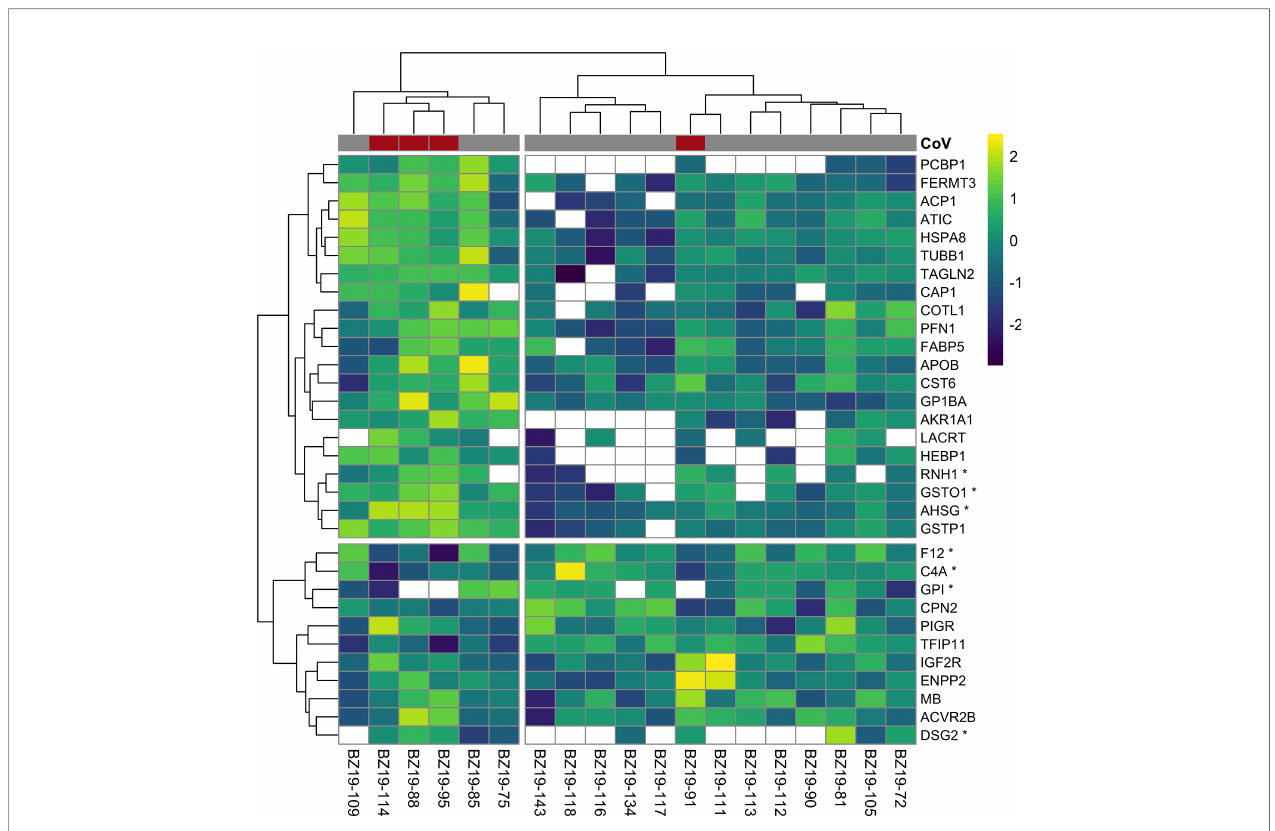
FIGURE 3 | Heatmap of log 2 -transformed abundance for all candidate serum biomarkers of CoV infection ( n = 32), scaled to a mean of zero. Rows display individual bats, while columns display proteins as gene symbols; those with AuROC ≥ 0.9 are marked with an asterix. CoV infection status is shown at the top of the heatmap. Clustering used Ward ’ s hierarchical method (71). Missing abundance values are shown as